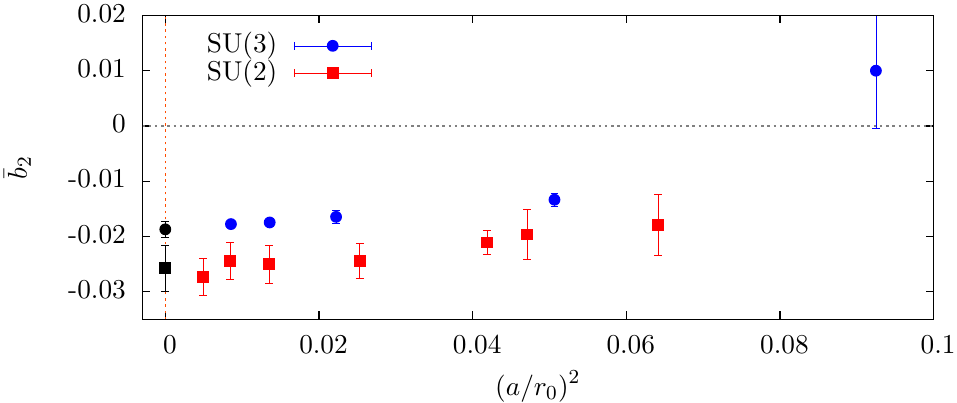
Figure 5 . Results for (cid:22) b 2 from table 7 versus the squared lattice spacing in units of r 0 . Also shown are the continuum results from eq.